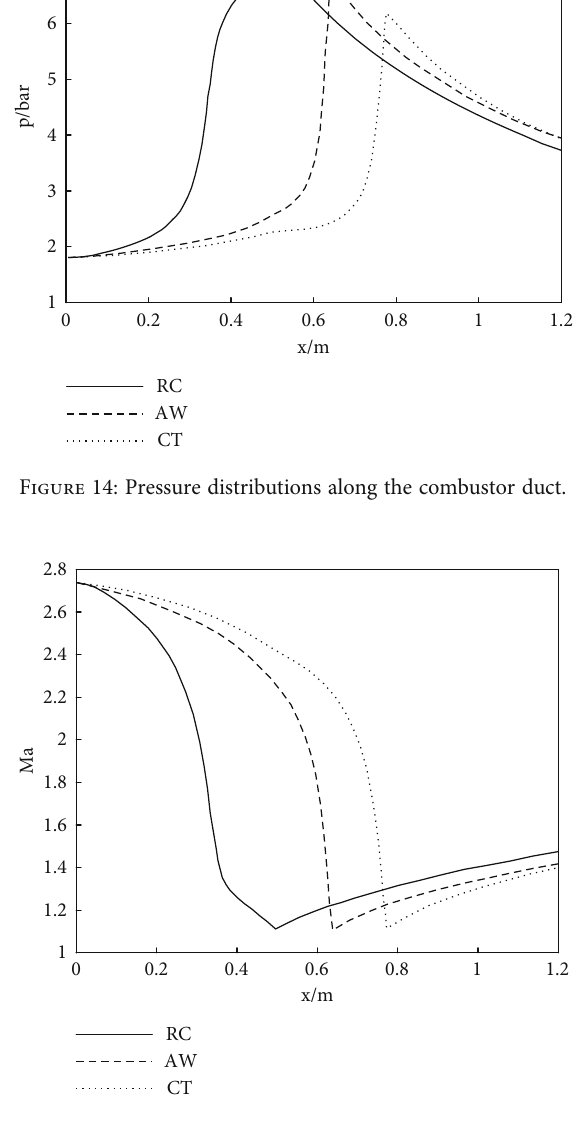
Figure 15: Mach number distributions along the combustor duct.